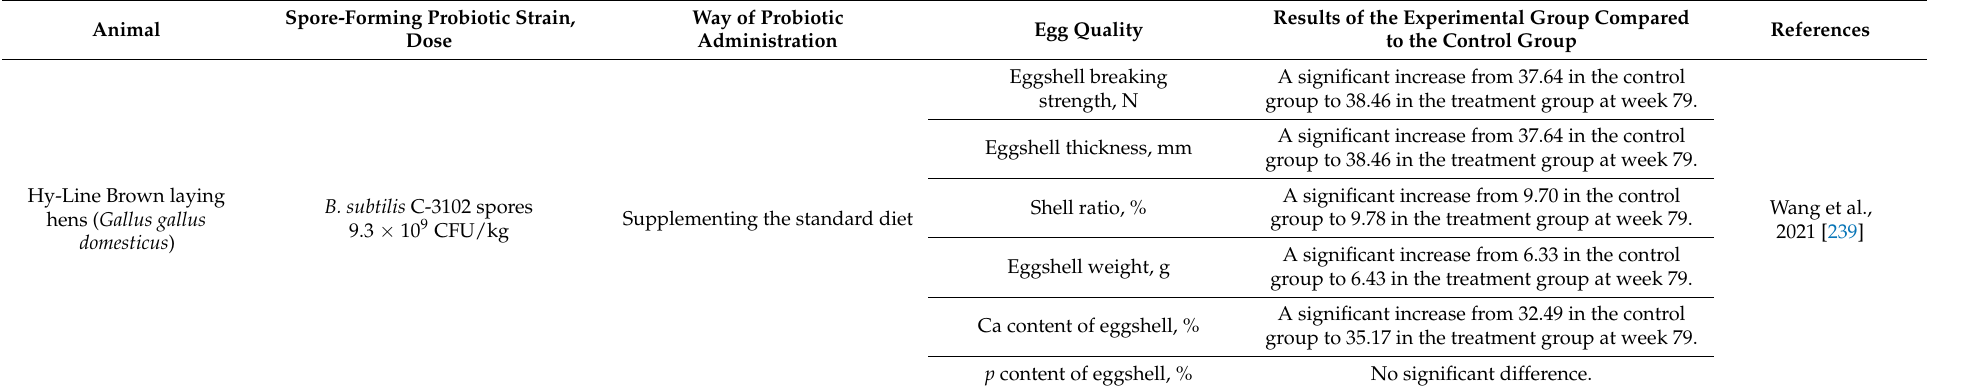
Table A2. Comparison table of studies of spore-forming probiotics effects on egg quality characteristics in